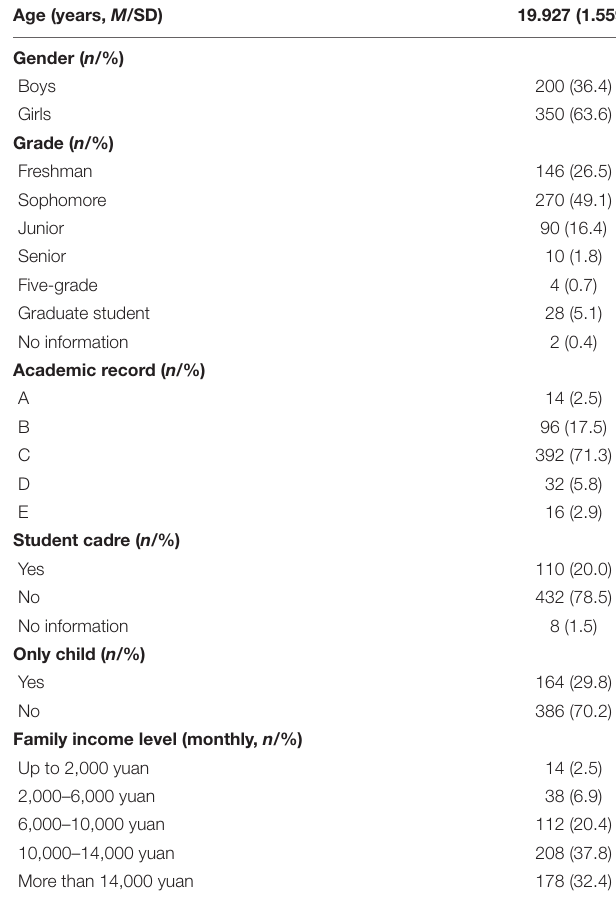
TABLE 1 | Sociodemographic characteristics of the sample ( n =